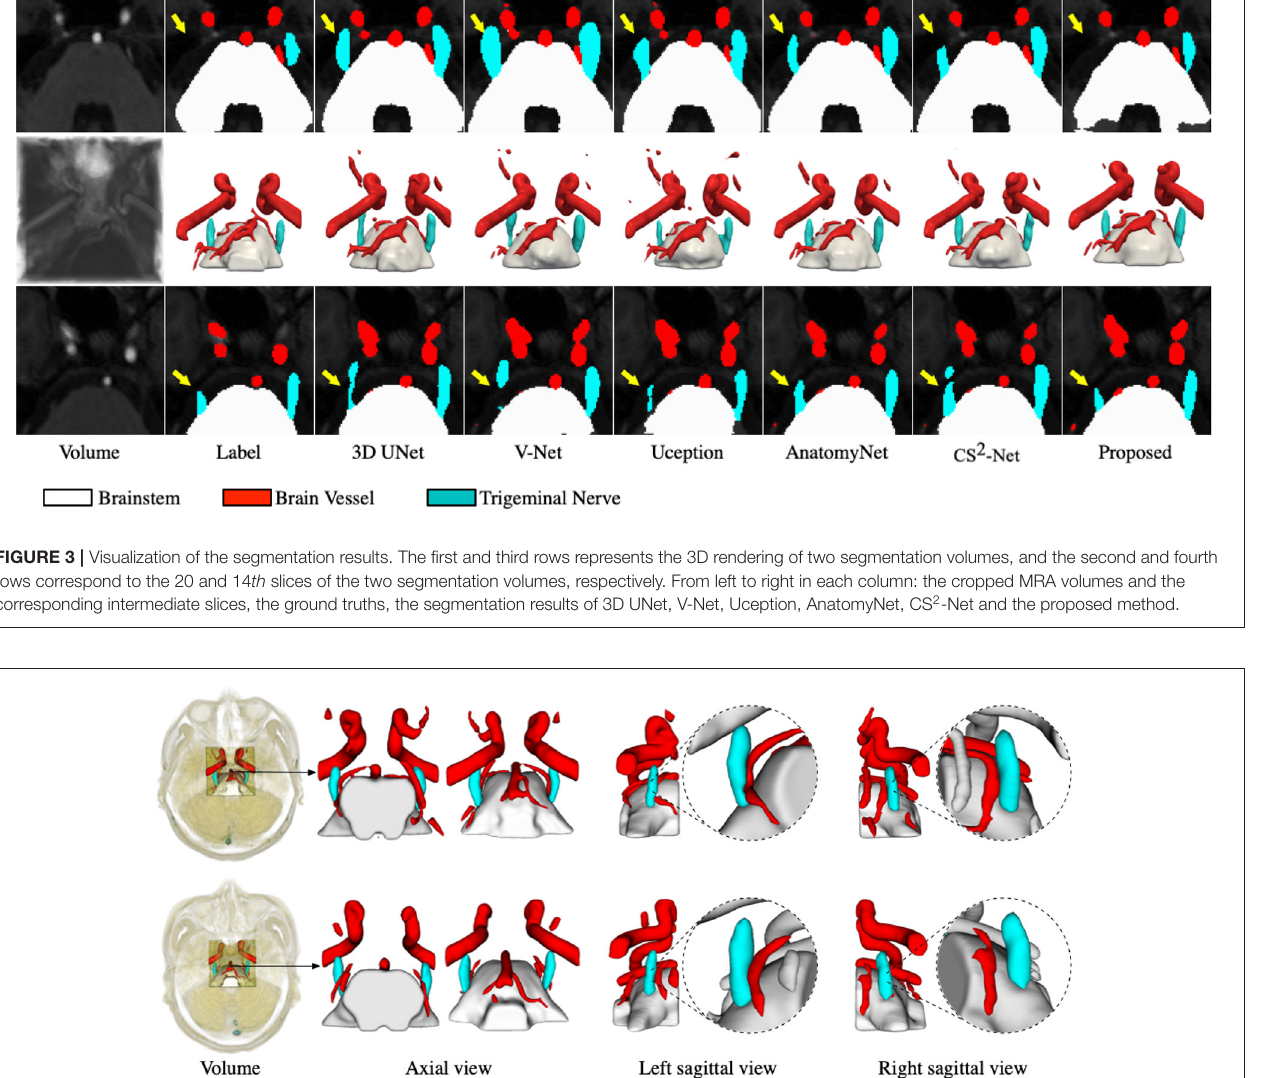
for the second case, the rendering from its sagittal view visually shows that neurovascular compression exists on the left side while no compression is identified on the right side, which also coincides with the diagnosis of left-side trigeminal